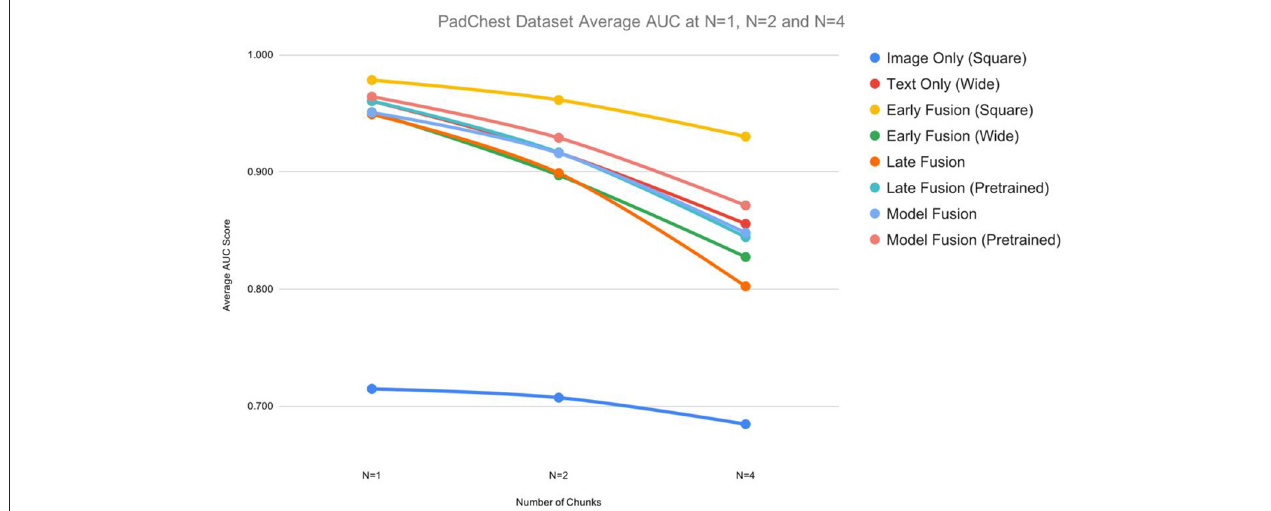
FIGURE 6 | Averaged AUC scores for the PadChest dataset for n ε {1,2,4}.